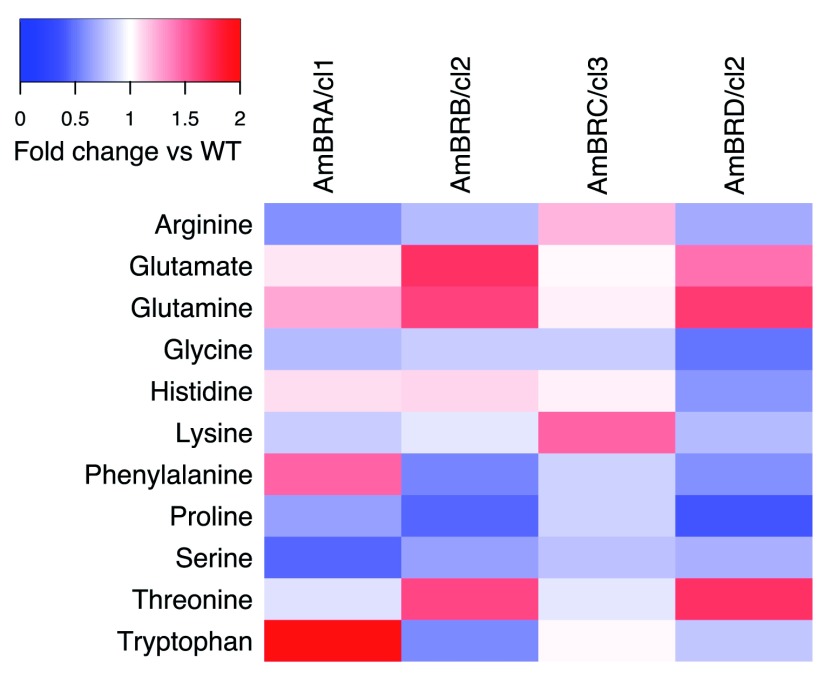
Heatmap of fold changes in amino acid intensity.Proteogenic amino acids with a Benjamini-Hochberg-corrected p-value (q-value) < 0.05 for ANOVA, and at least one Tukey’s Honest Significant Difference test comparing to wild-type with p-value < 0.05 are included (note that L- and D- isomers cannot be distinguished by this LC-MS method). Fold changes are in comparison with wild-type
L. mexicana, with red representing increased abundance, and blue representing a decrease.